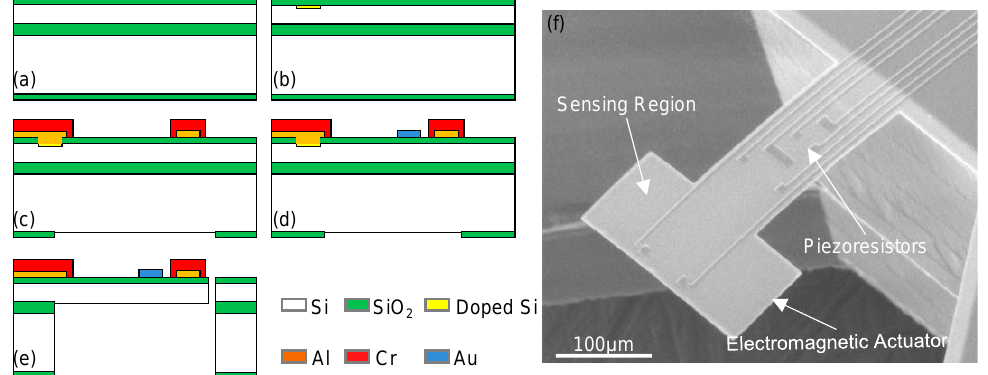
Figure 3. Torsional-mode cantilever mass sensors. ( a – e ) Fabrication process of the microcantilevers showing on-chip integration of electromagnetic excitation and piezoresistive readout. ( f ) Typical resonant sensor with 2 sensing regions for nanomaterial loading. Reprinted with permission from [17]. Copyright 2007 American Institute of Physics.